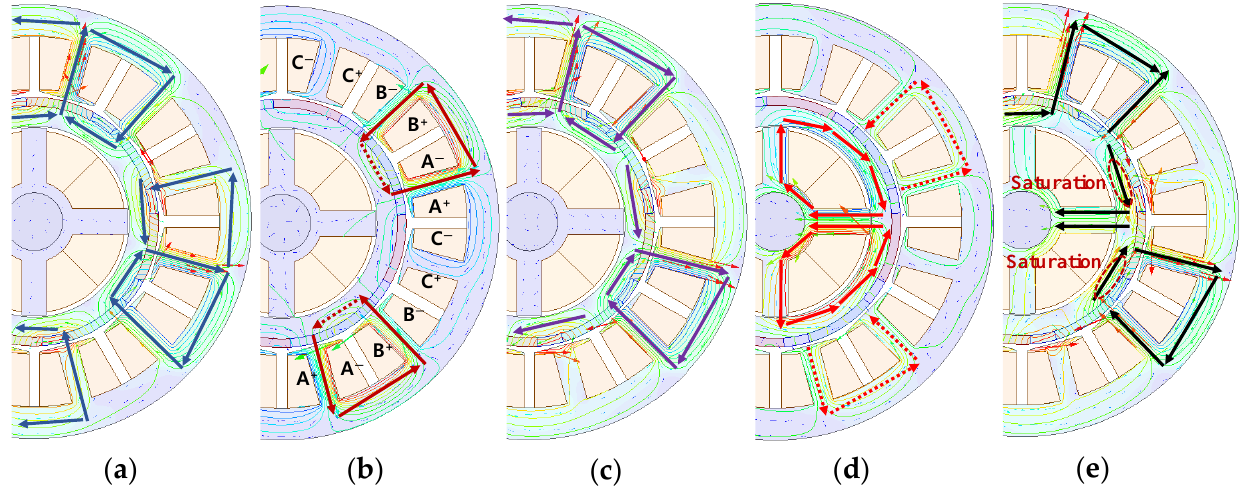
Figure 5. Flux line according to magnetomotive force at rotation angle 248° electric: ( a ) Magnet; ( b ) stator; ( c ) magnet, stator; ( d ) bearings; ( e ) bearings, magnets, and stators.